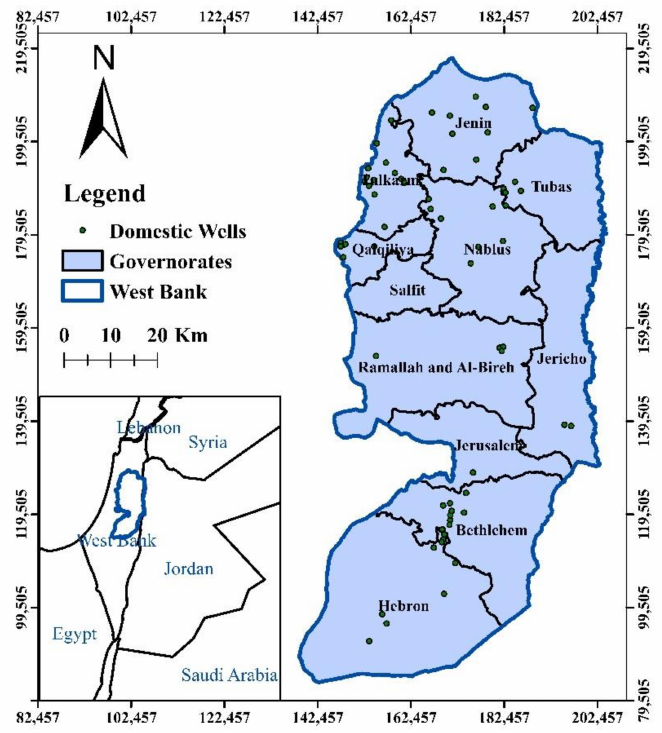
Figure 3. Regional location of the West